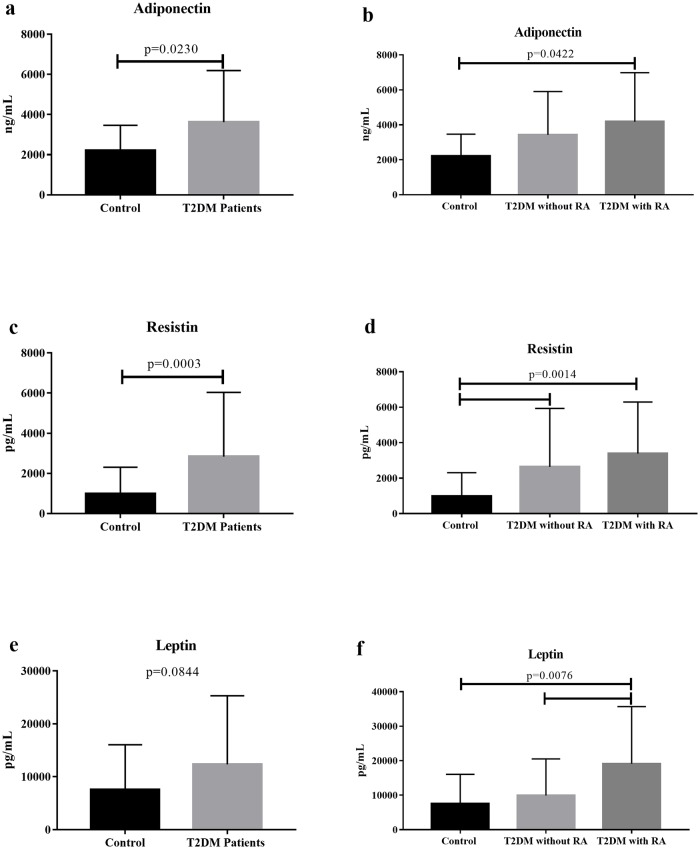
Serum adipokine levels in T2DM group without and with RA and control group.(a) Serum adiponectin levels in T2DM patients and controls and (b) T2DM patients without and with RA vs. controls. (c) Serum resistin level in T2DM patients and controls and (d) T2DM patients without and with RA vs. controls. (e) Serum leptin level in T2DM patients and controls and (f) T2DM patients without and with RA vs. controls. The results were expressed as mean ± standard deviation. RA, renal alteration.